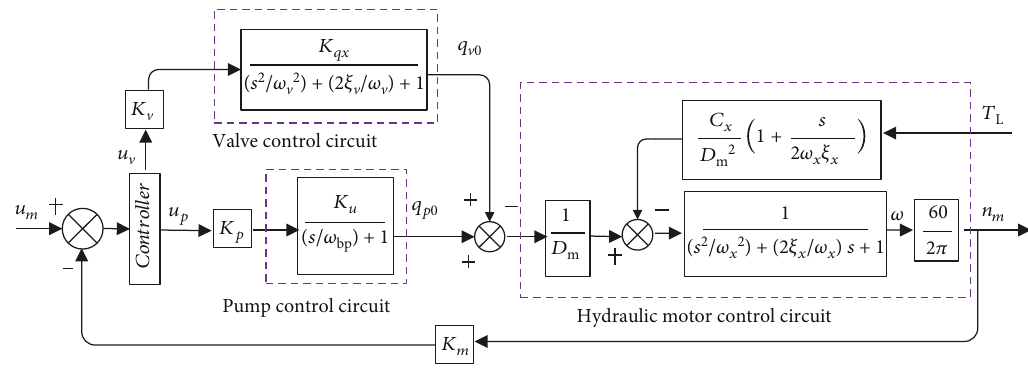
Figure 4: Block diagram of the valve-pump parallel variable mode control